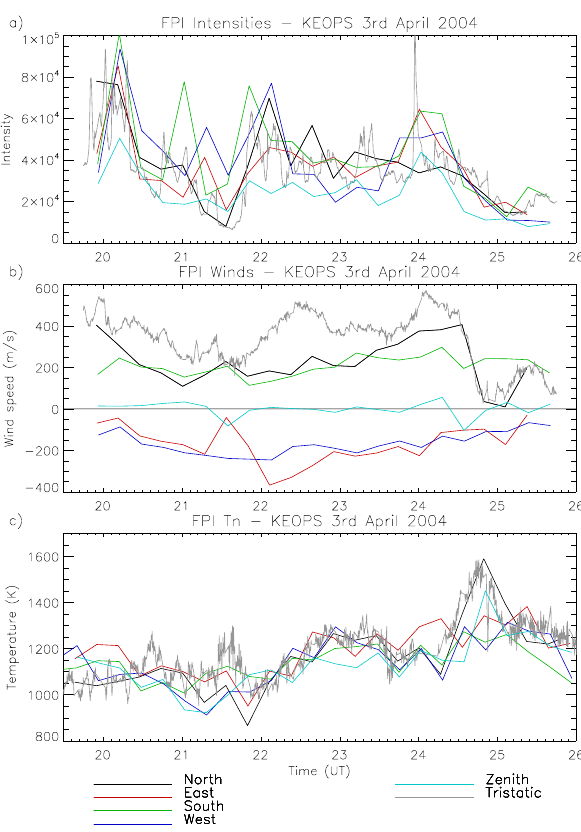
Fig. 3. 1h of high resolution FPI data from KEOPS on 3 April 2004, including 0.1h (6min) interpolated tristatic data: (a) intensities, (b) winds, and (c)